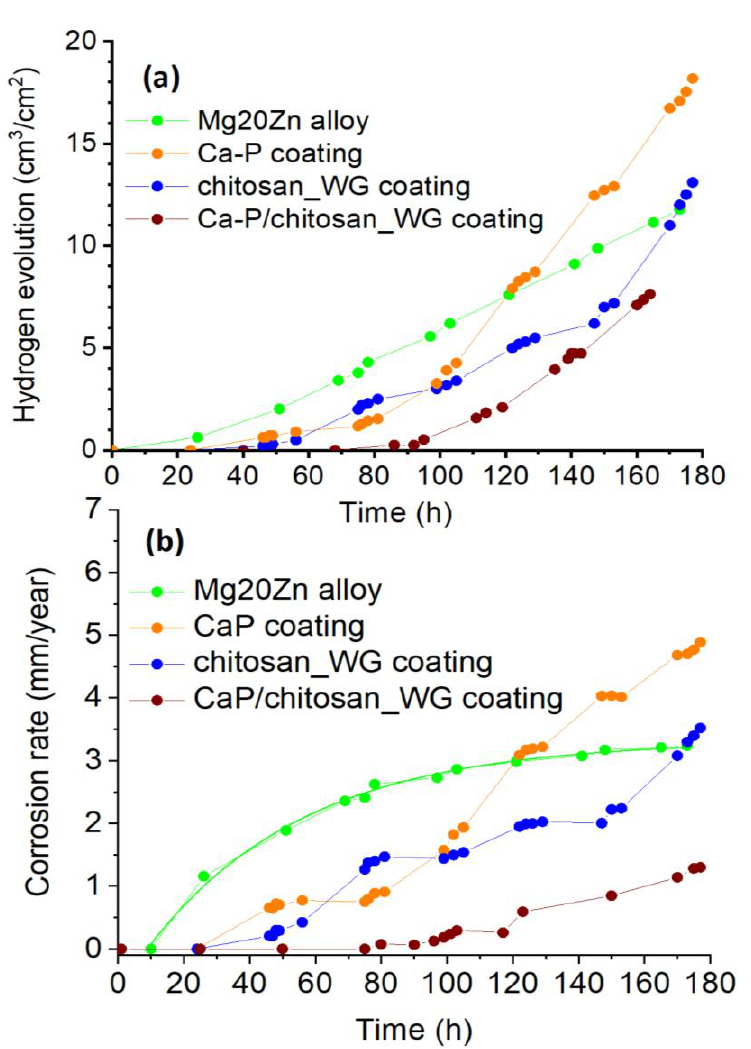
Figure 6. ( a ) Hydrogen evolution vs. time for the Mg20Zn alloy and the different coatings immersed at the OCP in the Hank’s solution at 37 °C. ( b ) Evolution of the calculated corrosion rate vs. time.